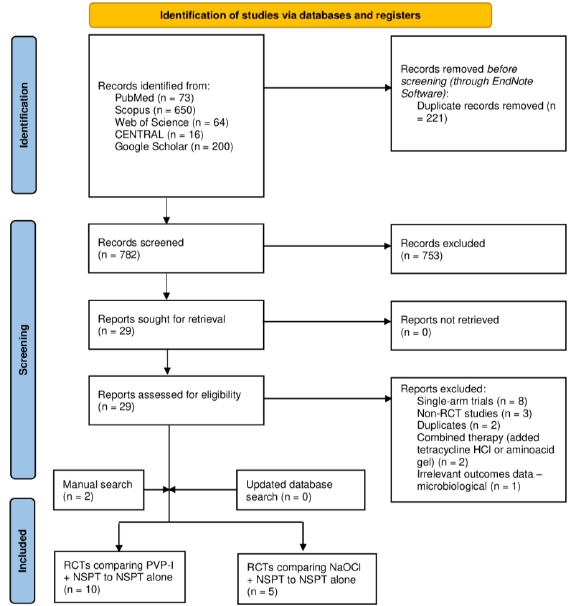
Figure 1. A PRISMA flow diagram of the database search and screening processes. RCT: randomized clinical trial. PVP-1: Povidone-Iodine. NSPT: non-surgical periodontal treatment. NaOCL: sodium hypochlorite.